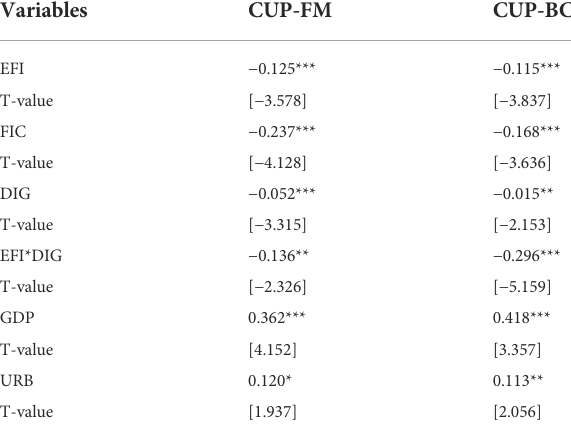
TABLE 6 Results of CUP-FM and CUP -BC Tests, DV: